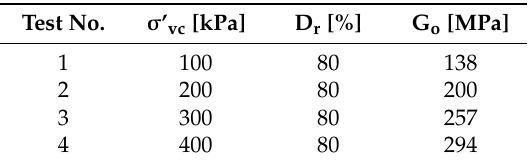
Table 2. Test Condition for Scortichino—Bondeno